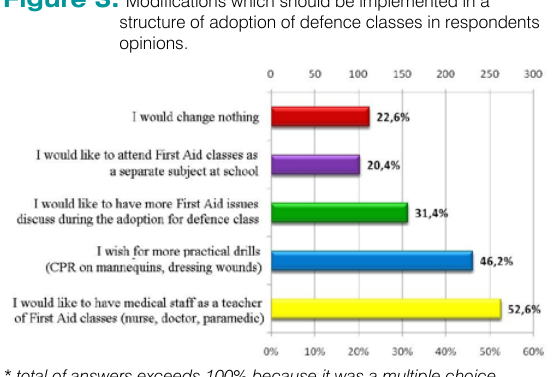
Figure 3. Modifications which should be implemented in a structure of adoption of defence classes in respondents